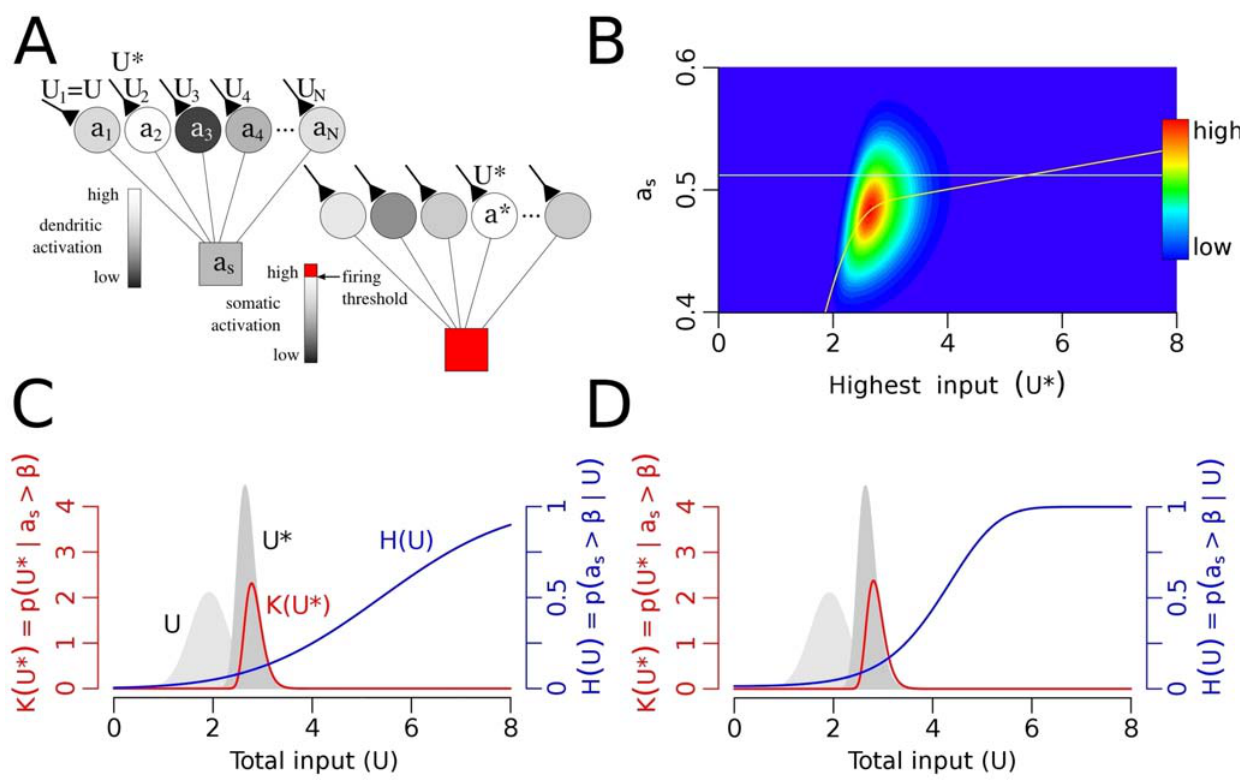
Figure 2. Input strength encoding with uniform synapses. (A) The figure shows two neurons (or the same neuron with two different input sets). We calculated the probability of firing ( H ( U )) given that one of the branches has exactly U synaptic input (e.g., U 1 = U ) while inputs of other branches ( U 2 , U 3 , …, U N ) are drawn independently from the input distribution. Second, we calculated the distribution of the maximal input ( K ( U * )) given the depolarization of the soma exceeds the firing threshold. (B) Color coded joint probability distribution of the somatic activation and the maximal dendritic input, p [ a s , U * ] with the linear integration function. Red is maximum, dark blue is zero. The color-code emphasizes low probability events and it is not linear. The horizontal line is the firing threshold; the yellow line shows the conditional expectation of a s given U * . If dendrites were independent high and low U * values could be separated by a somatic threshold of action potential generation. (C–D) Dendritic independence with linear (C) and quadratic (D) integration functions. Left axis, red: K ( U * ), the distribution of the maximal dendritic inputs during firing. Right axis, blue: the H ( U ) function, which is the probability of firing given that one of the dendrites has U total input. The probability of triggering output by a single branch is low ( H ( U ) , 0.25) even with reasonably large input (as revealed by the low H ( U ) values at the probability mass of K ( U * )). This indicates that a single dendritic subunit is unable to reliably activate the neuron with these integration functions. Background light gray is the distribution of U while dark grey shows the distribution of U * . Parameters: R =0.01, N